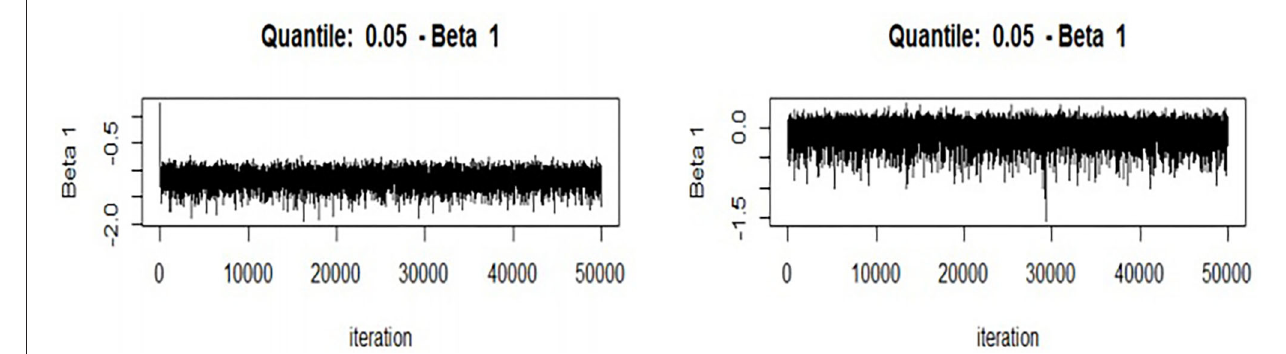
FIGURE 5 | Markov chain fitting degree diagram.